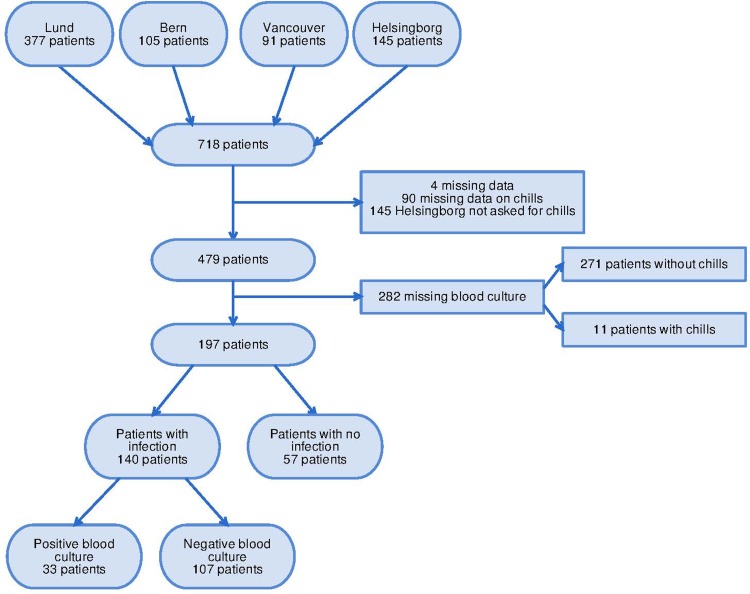
Flow chart of patients in the study cohort.